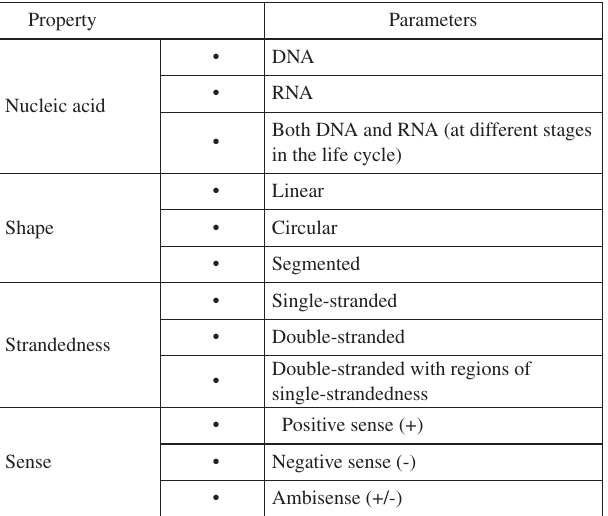
Table 1. Genomic diversity among viruses Property